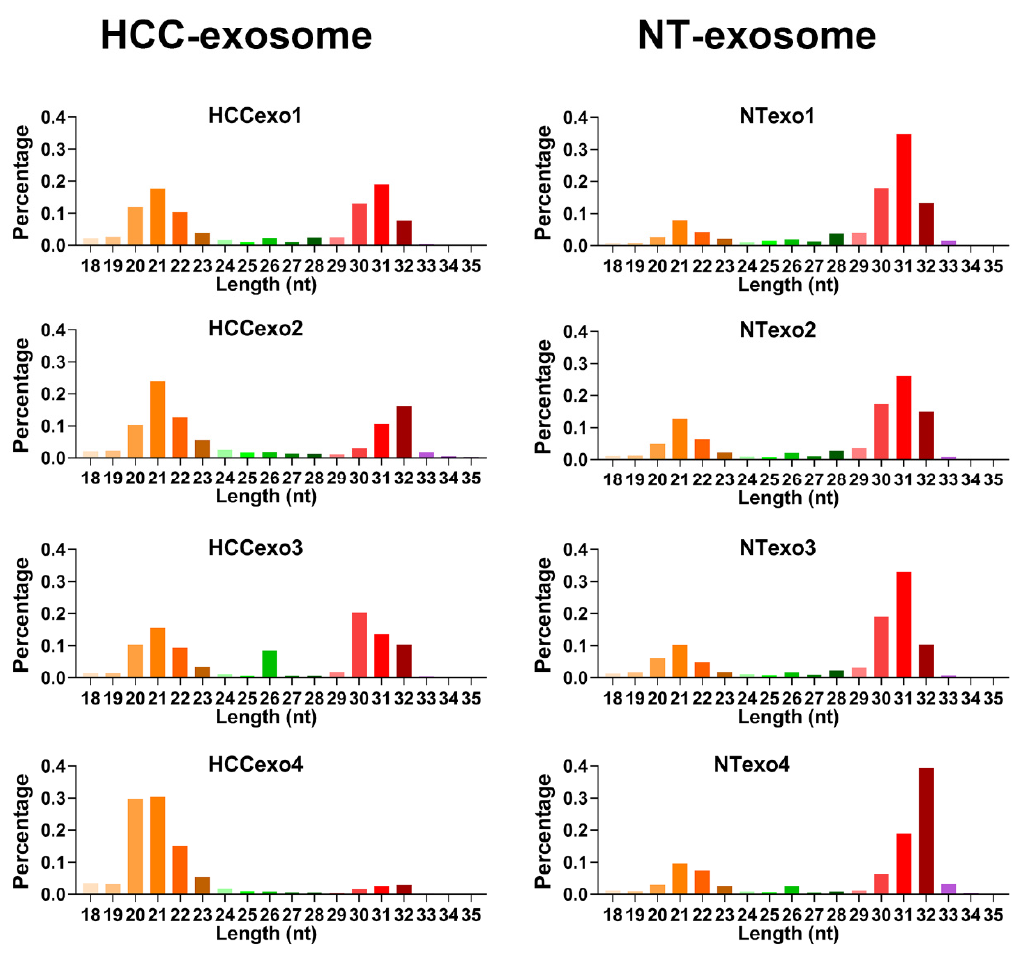
Figure 2. sRNAs’ length distribution of serum exosomes from four HCC patients and four non tumor donors.